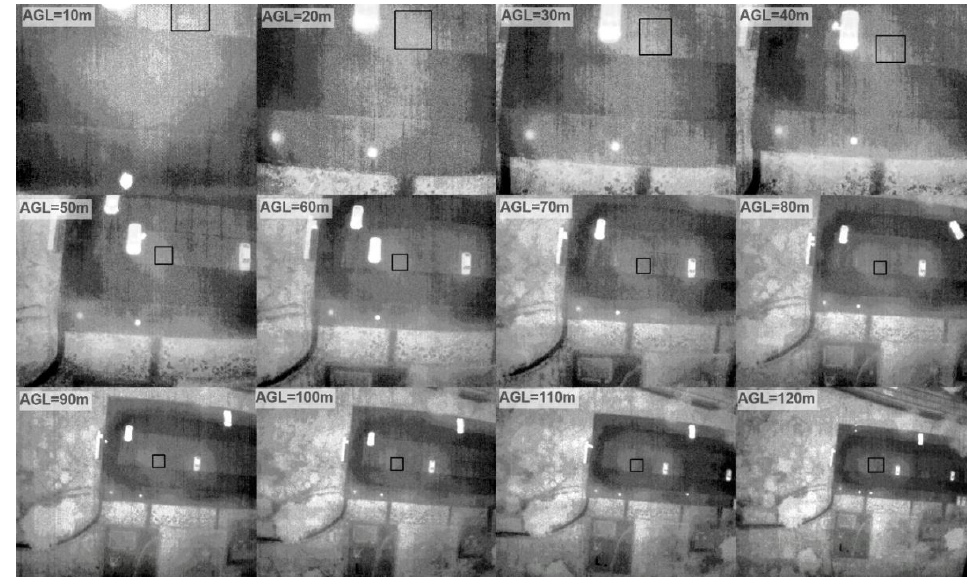
Figure 9. An example of a series of photos taken above the reference surface (black polygon) and the method of measuring its temperature taking into account the shrinkage of its image as in subse- quent photos recorded from a higher altitude (from 10 to 120 m AGL).